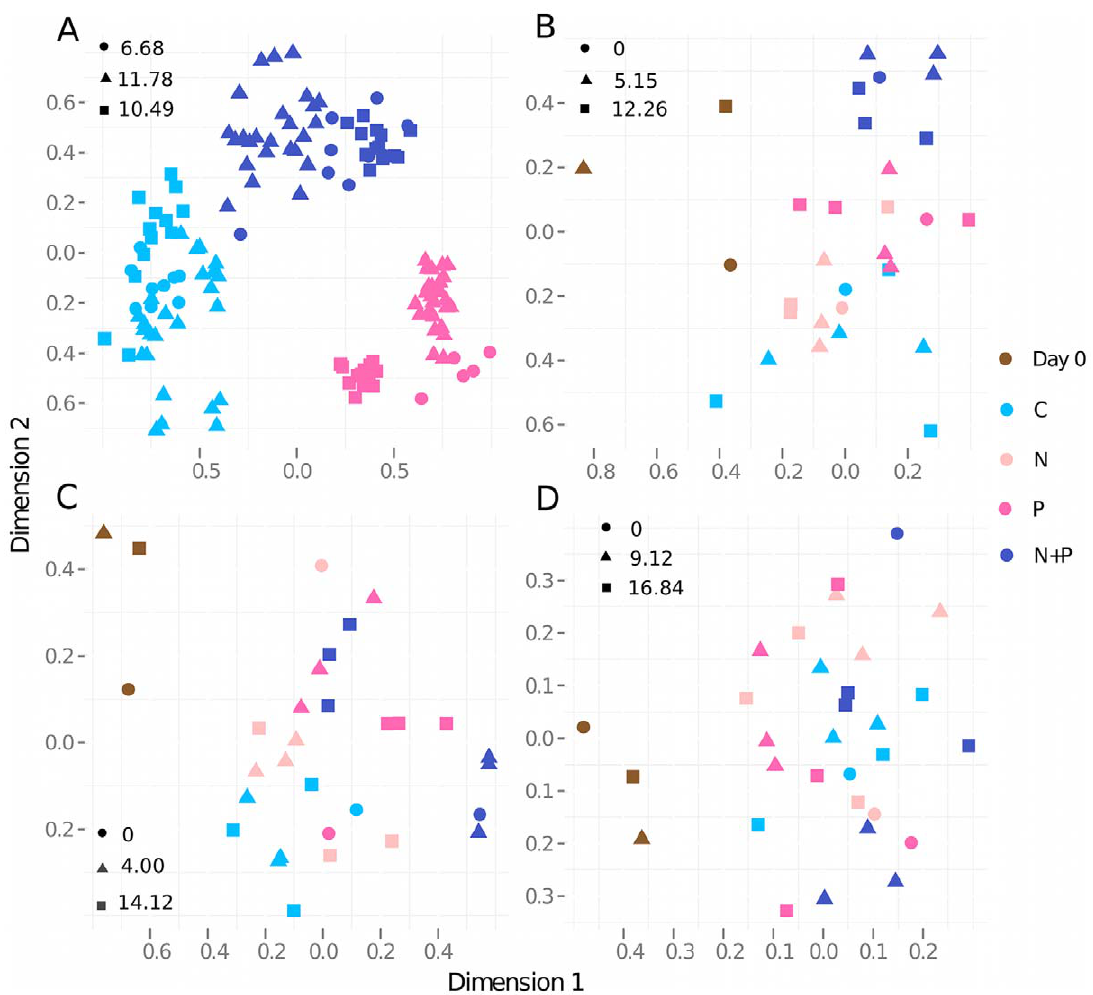
Figure 3. Overlaid non-metric multidimensional scaling plots from 454 pyrosequencing, LH-PCR and phytoplankton data. All three datasets and experiments are overlaid in a single plot with different colours representing experiments (May: light blue, July: dark blue and September: pink) and different shapes representing datasets (A). In panels visualizing May (B), July (C) and September (D) experiments colours represent treatments as in legend and shapes represent datasets. Dissimilarities in community composition were estimated using Morisita-Horn distance metric. Stress values for each community (indicated with shapes) are specified in plots. In all plots & = phytoplankton.